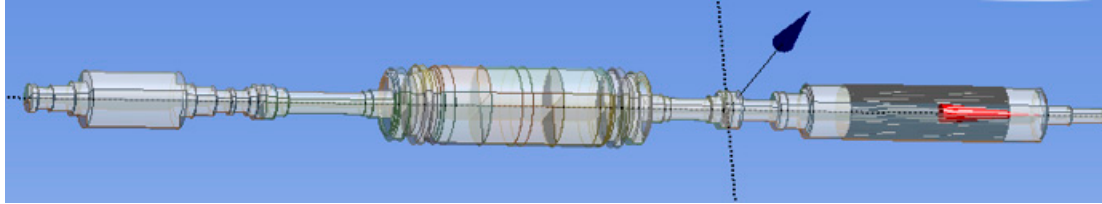
Figure 7. Sliced shaftline.